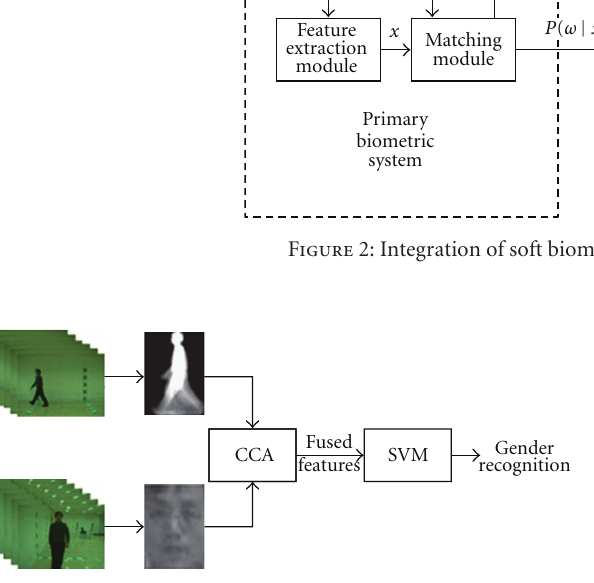
Figure 3: Gender recognition using face-gait